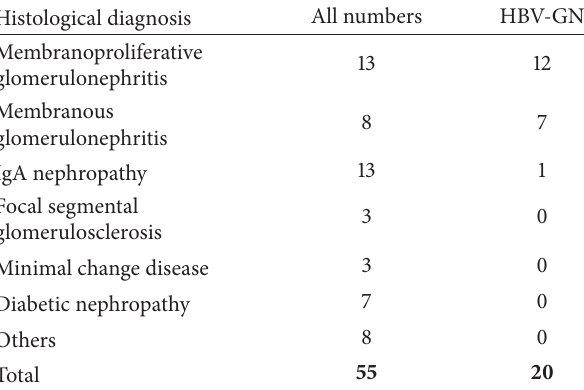
Table 2: Frequency of HBV-GN among patients with proteinuria and hepatitis B and diagnostic distribution of renal pathologies in HBV-GN